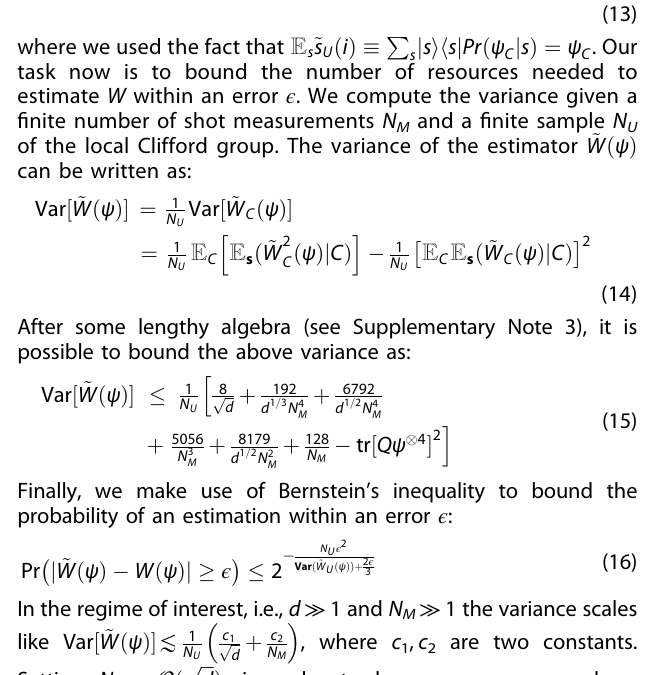
Experimental protocol . To measure the magic of multiqubit states on a quantum processor via statistical correlations